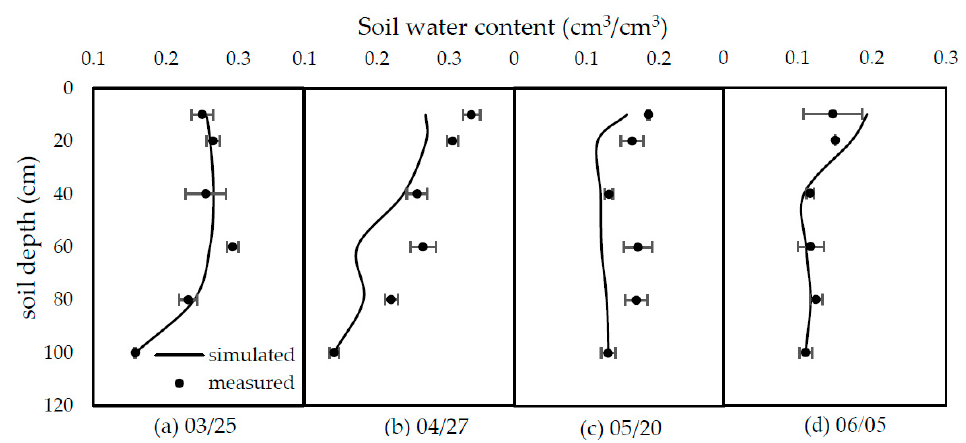
Figure 10. Comparison between simulated and measured soil water content of different soil layer in W1 treatment. ( a – d ) is March 25, April 27, May 20 and June 5, respectively.